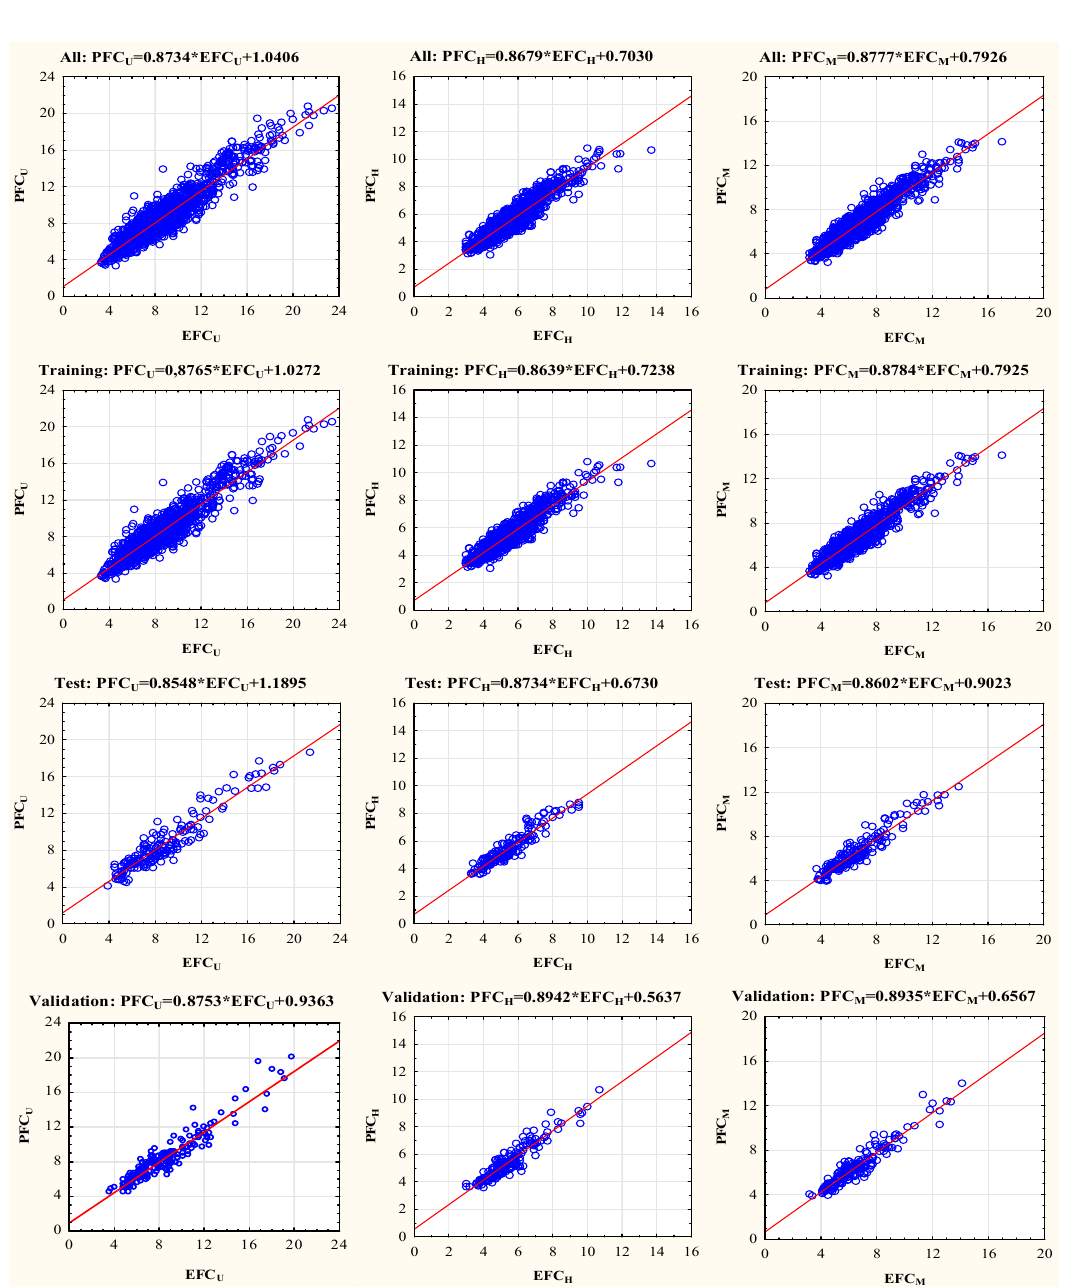
Figure 6. Regression plots of the MLP 22-10-3. For the purposes of determining the magnitude of impact of individual input vari- ables on the accuracy of the predictive model, a global sensitivity analysis was conduct- ed. The results of the analysis are presented in Table 7. The sensitivity coefficient W j of the Gearbox T G variable is equal to exactly 1, which means that this variable has no im- pact on the MSE error of the prediction.